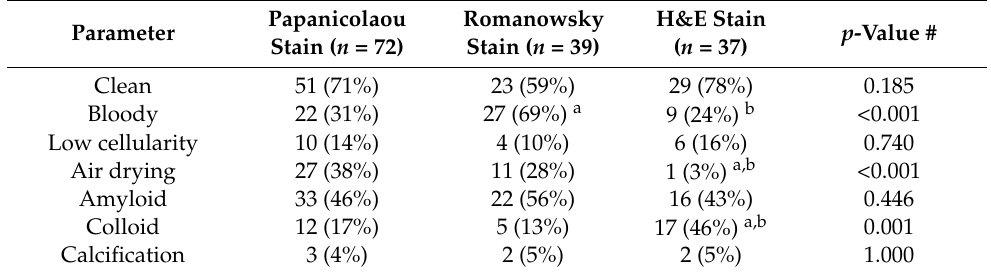
Table 3. Background characteristics by different staining methods (accurately categorized specimens, total n =